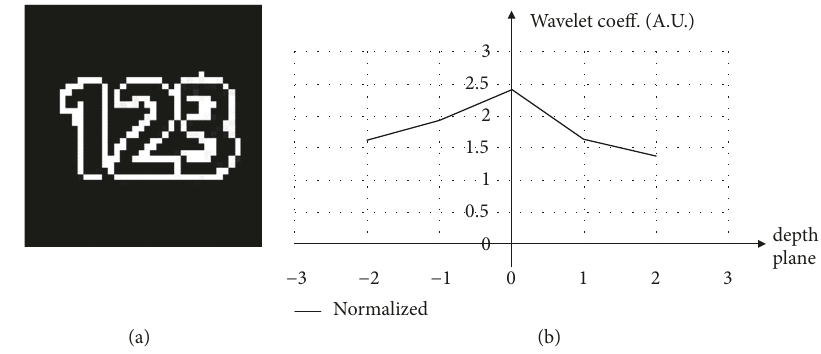
Wavelet coeff. (A.U.)